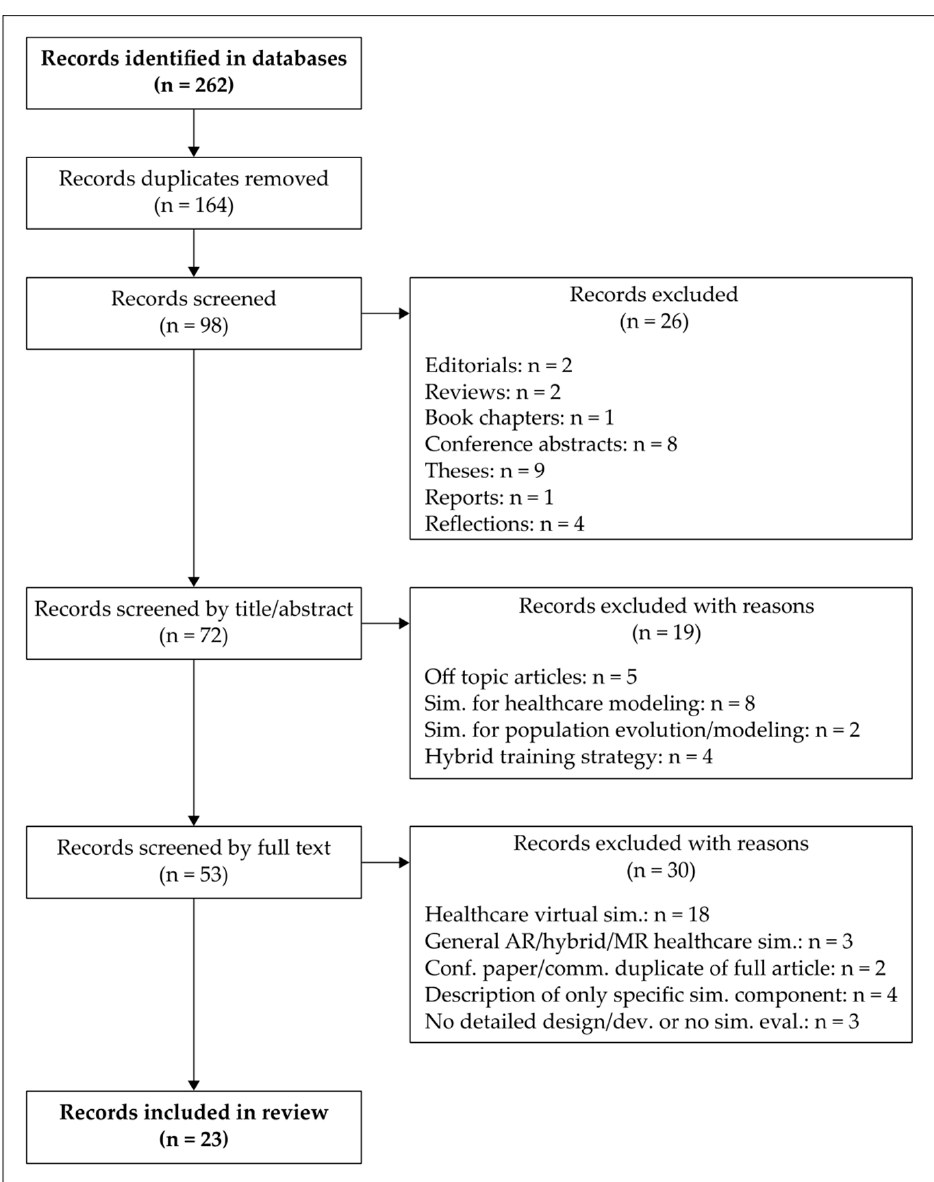
Figure 1. Flow chart illustrating the selection of studies according to PRISMA statements.